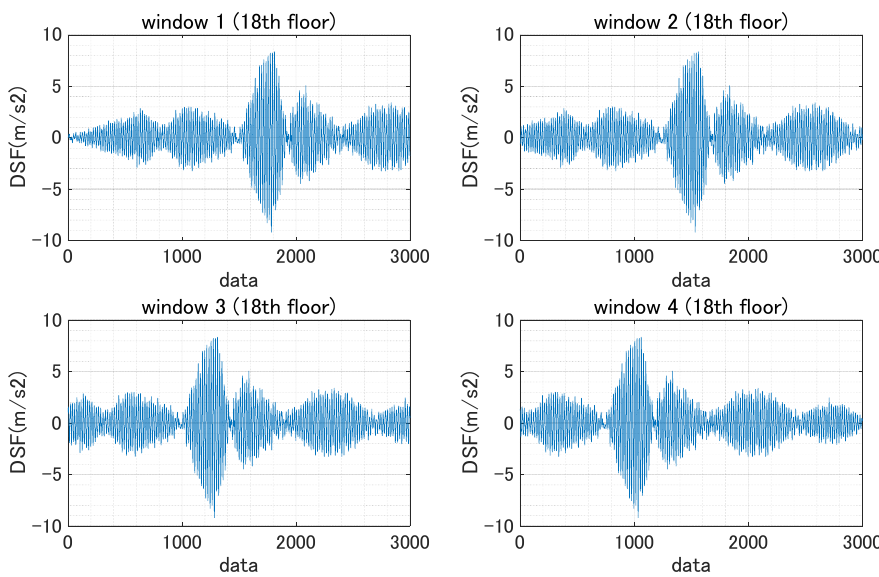
Figure 12. Example of four windows (3001 data points) selected to contain the maximum acceleration of DSF for Experiment 2.